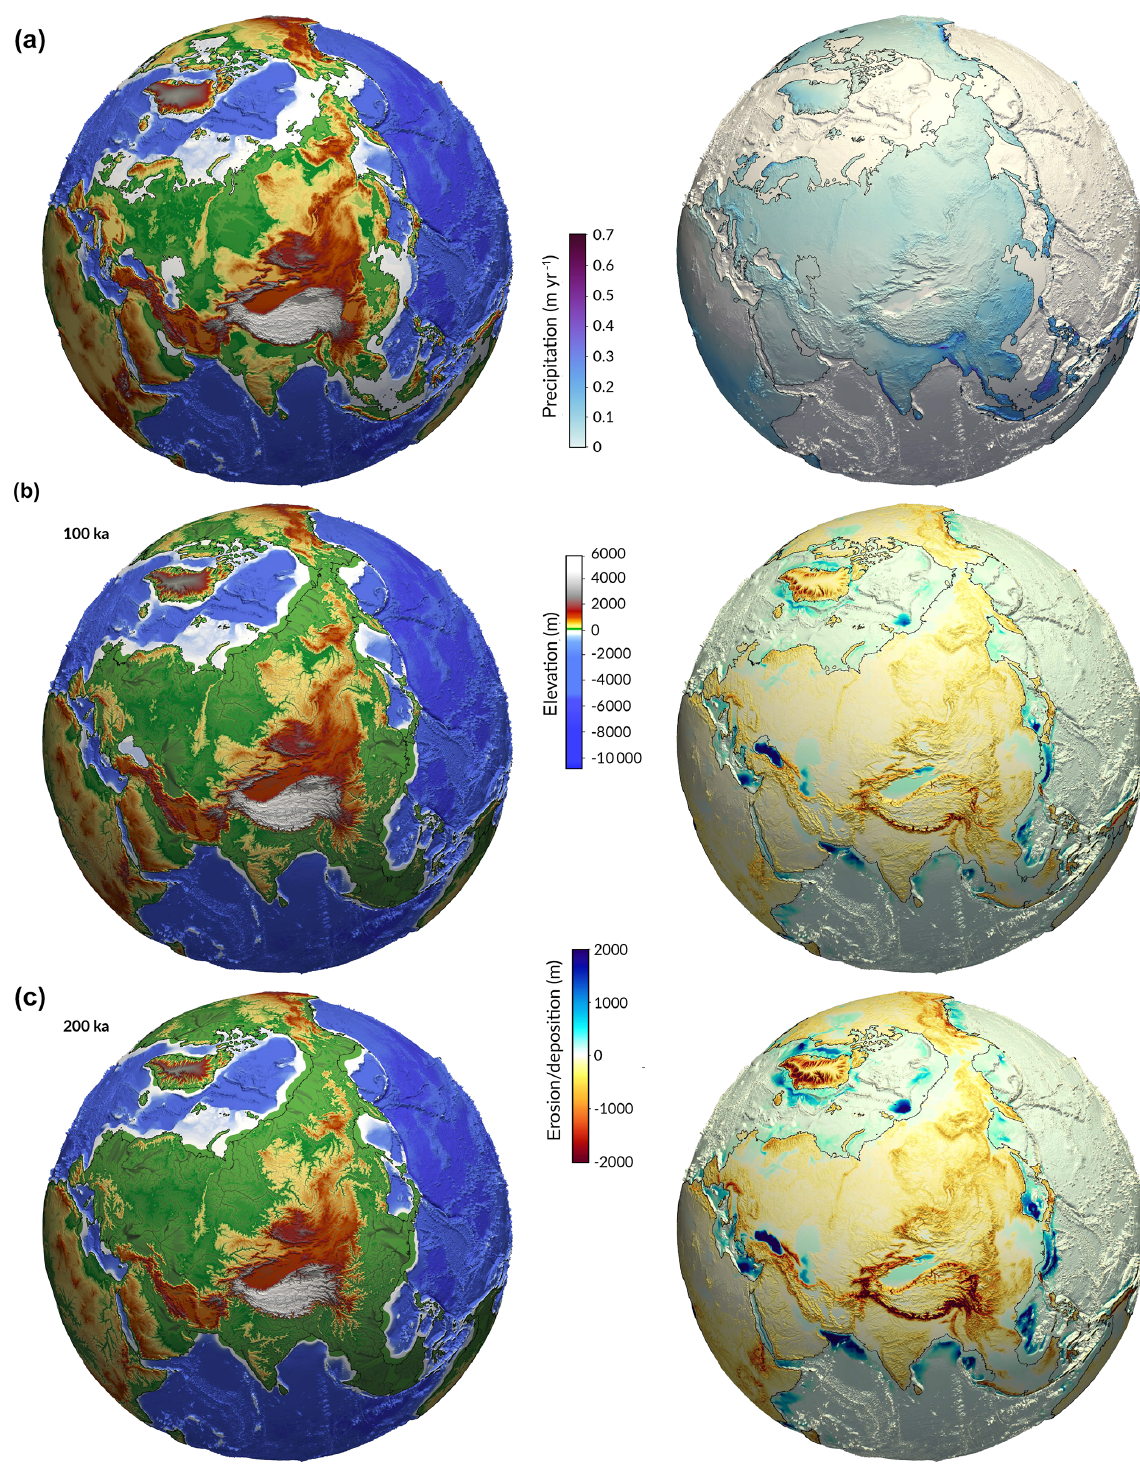
Figure 6. Similar to Fig. 5 from a different